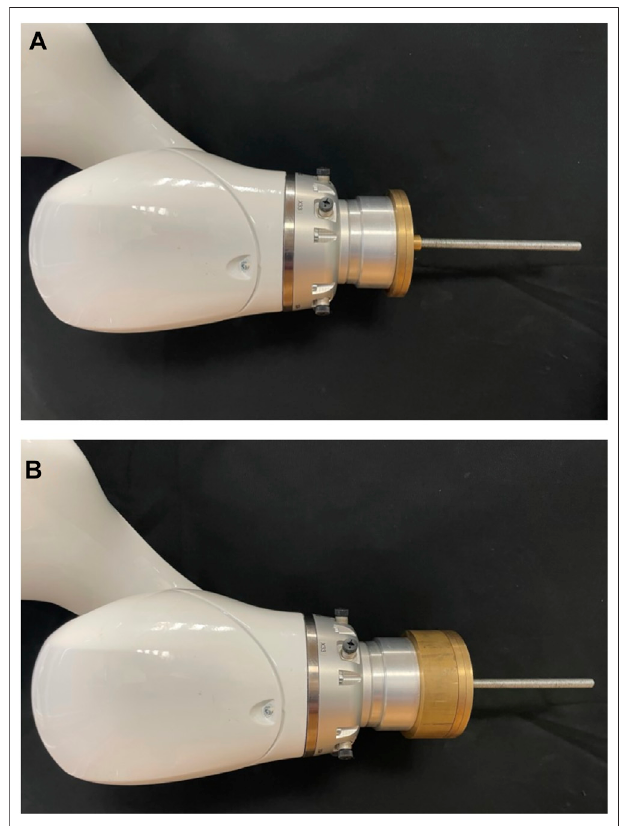
FIGURE2 | Calibration weights were stacked on a metallic rod attached to the end-effector of the robot to generate 10 equidistantly distributed end- effector forces in our target range from 0 – 20 N. Examples of appropriately stacked calibration weights to generate an end-effector force of 8 N (A) and 18 N (B) are